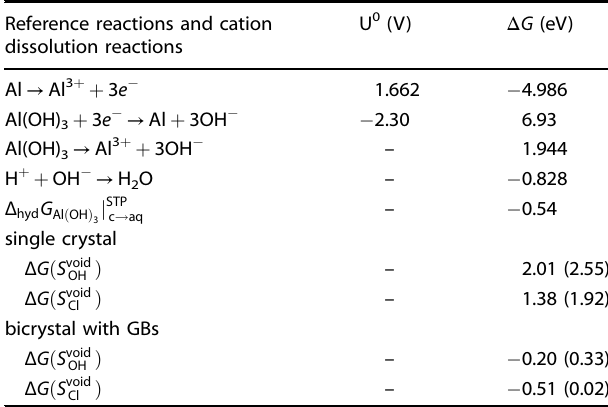
Table 2. Reference energies and reaction free energies described in Eq. (15) and Eq. (18) at STP